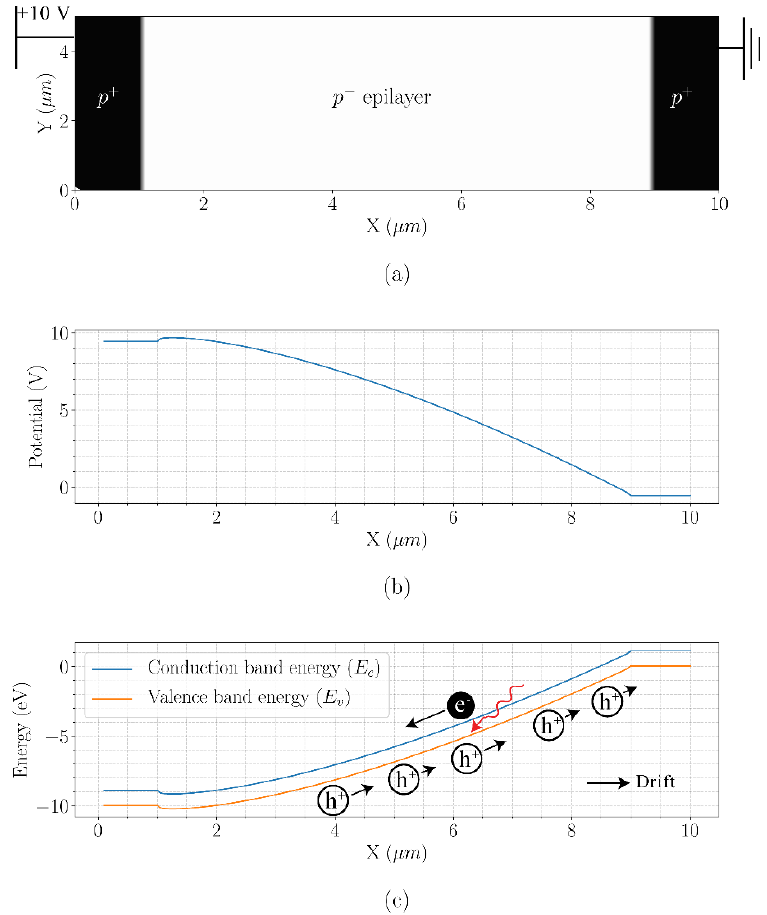
Figure 2. Cross-section of a simple p-i-p structure ( a ), the potential as a function of X (at any point in Y) ( b ) and the corresponding conduction and valence band energies with overlaid illustration of current-assistance operation ( c ).